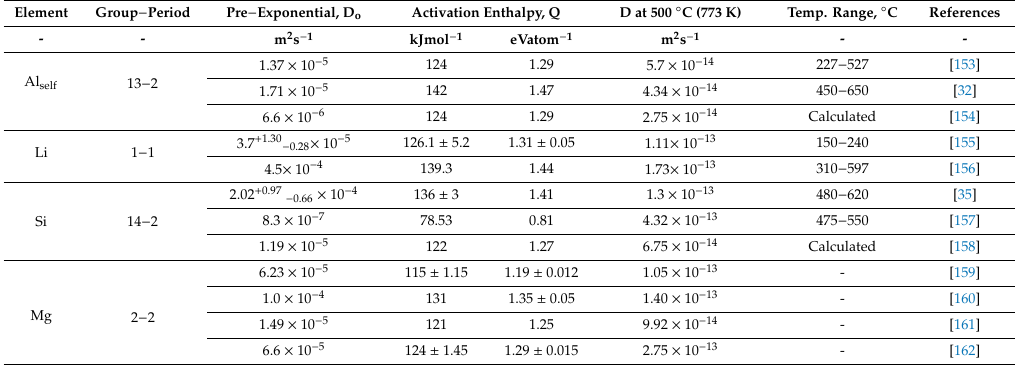
Table A1. Measured di ff usivities of selected elements along with Al self-di ff usion (data calculated are indicated).